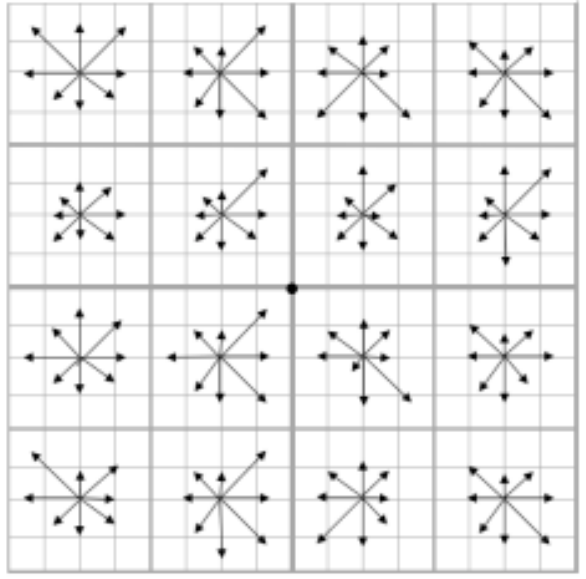
Figure 2. SIFT local feature